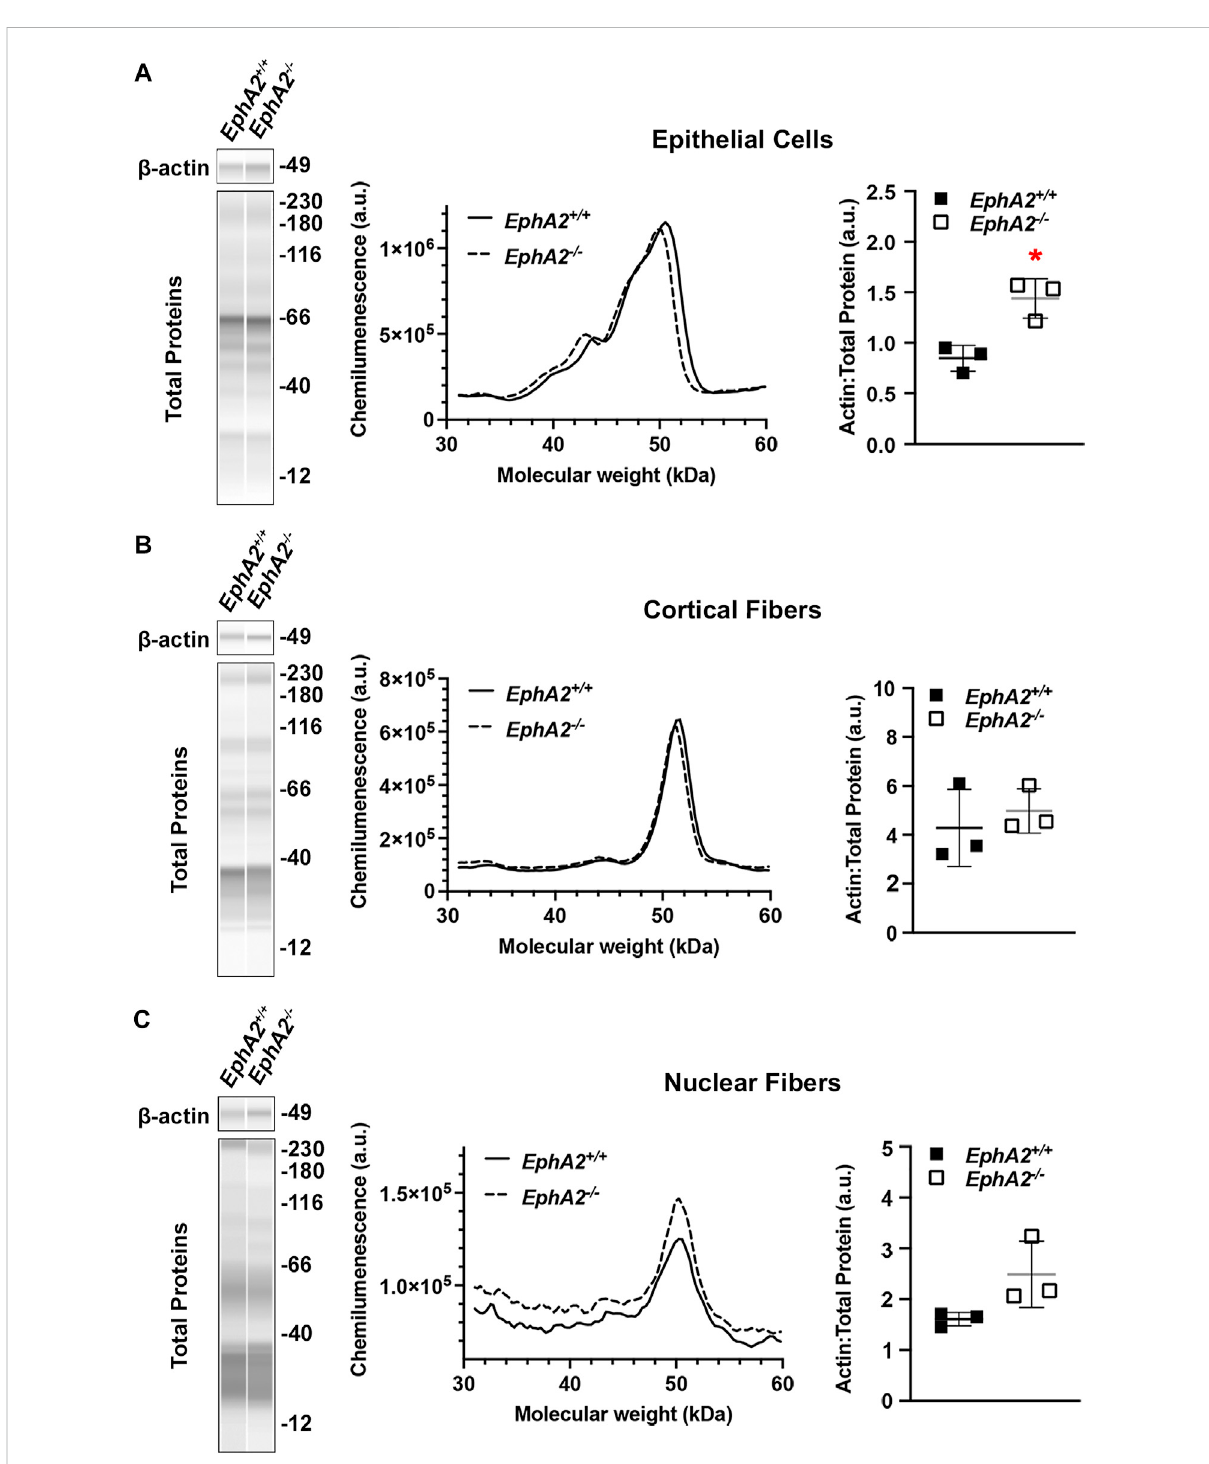
FIGURE 6 Analysisofepithelial,cortical fi ber,andnuclear fi berproteinsamplesbycapillaryelectrophoresis.Representativegelbandsfor β -actin(~49 kDa) and totalproteinpro fi les (12 – 230 kDa)from eachfraction are presented inpseudo-lane views. Normalwild-type(+/+) control lenses are compared to knockout ( − / − ) lenses. All mice were littermates and 4 months old. (A) Representative electropherogram of β -actin peaks from the epithelial cell fraction is plotted for control (+/+) and knockout ( − / − ) samples. The β -actin protein amount normalized to total protein is plotted on the dot plots with lines showing theaverage and standard deviation. The knockout samples showedincreased amount of β -actin in theepithelial cells. *, p < 0.05. (B,C) Representative electropherograms of β -actin in cortical fi bers and nuclear fi bers from control and knockout lenses. Dot plots show the average and standard deviation for the normalized amount of β -actin in each sample. There is no difference in β -actin levels in control vs. knockout lenses in the cortical fi ber and nuclear fi ber